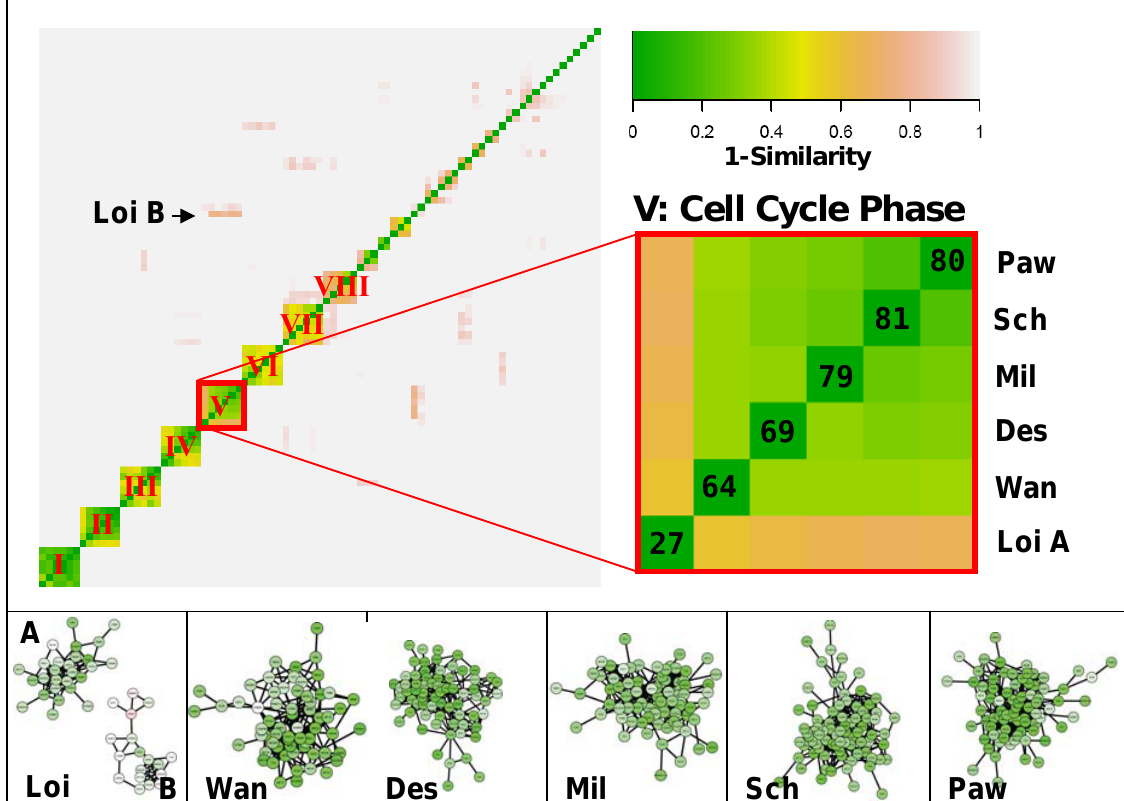
Figure 2: Pair wise similarities were calculated between sub networks obtained from the six studies using Jaccard indices. The resulting similarity matrix was hierarchically clustered and was depicted as a heat map in the upper left corner. The heatmap is symmetric along the diagonal and each row or column represents a unique sub network identified in one of the studies. The grouping belonging to cluster V (Cell Cycle Phase) is blown up to the right. Numbers on the diagonal indicate the number of genes within the identified sub networks. Extensive similarities are observed between sub networks from the six studies except for comparisons involving Loi, caused by the low number of genes found in the Loi study. Icons of sub networks at the bottom represent the sub networks for the different studies that were clustered together in cluster V, which are all also enriched for Cell Cycle Phase. Note that whereas for the Loi study two small sub networks were identified, others studies only returned a single large sub